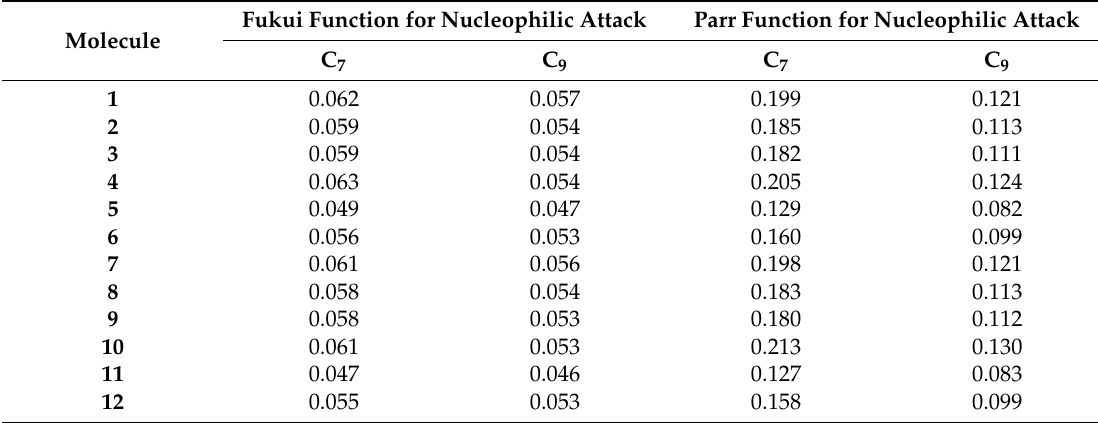
Table 4. Fukui function ( f + ) and Parr function ( P + ) for nucleophilic attack at C 7 and C 9 . Fukui Function for Nucleophilic Attack Parr Function for Nucleophilic Molecule